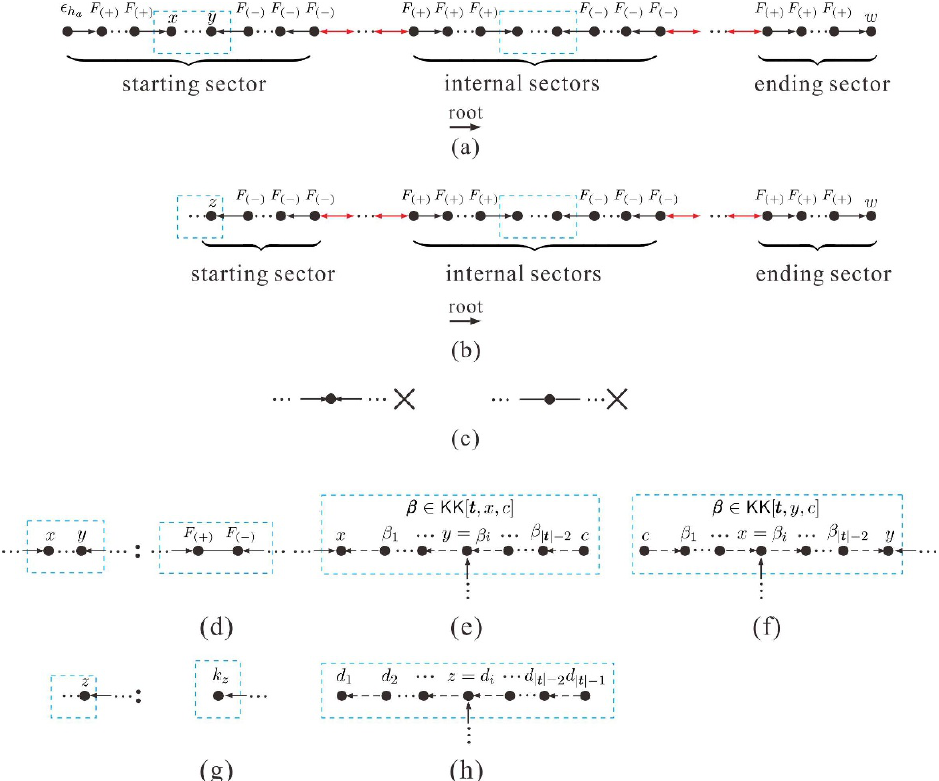
Figure 13 . The graph (a) is a chain that does not involve the highest-weight element H in (cid:26) ( l ) the reference order R . The graph (b) is a chain involving the highest-weight element. Each node (except for the ending node w ) outside the boxed structures in the chains (a) and (b) is a graviton and we de(cid:12)ne F (cid:22)(cid:23) (cid:17) k (cid:22) (cid:15) (cid:23) , F (cid:22)(cid:23) (cid:17) (cid:0) (cid:15) (cid:23) k (cid:22) . The structures shown by the graph (c) are not allowed. (+) ( (cid:0) ) Each boxed structure in the chain (a) and in an internal sector of the chain (b) can be (1). two gravitons connected together by a type-1 line (as shown by the graph (d)) or (2). a gluon trace in standard basis (as shown by (e) and (f) which correspond to the two terms in eq. (3.5)). The node c in (e), (f) denotes the (cid:12)xed node of a trace ttt . The boxed structure in the starting sector of (b) can be either a graviton (as shown by (g)) or a gluon trace ttt ! f d 1 ; d 2 ; : : : ; d g (as shown by j ttt j(cid:0) 1